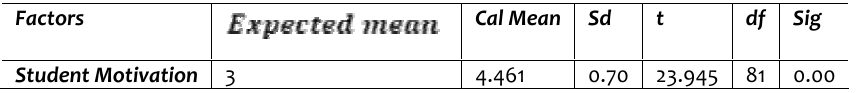
Table 3 - One sample t-test analysis of the contribution of ` motivation to students’ academic